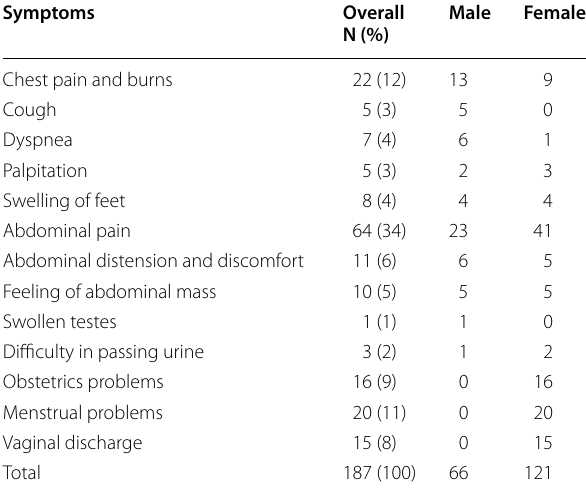
Table 3 Total amount of presenting symptoms in the sam- ple and their distribution among male and female